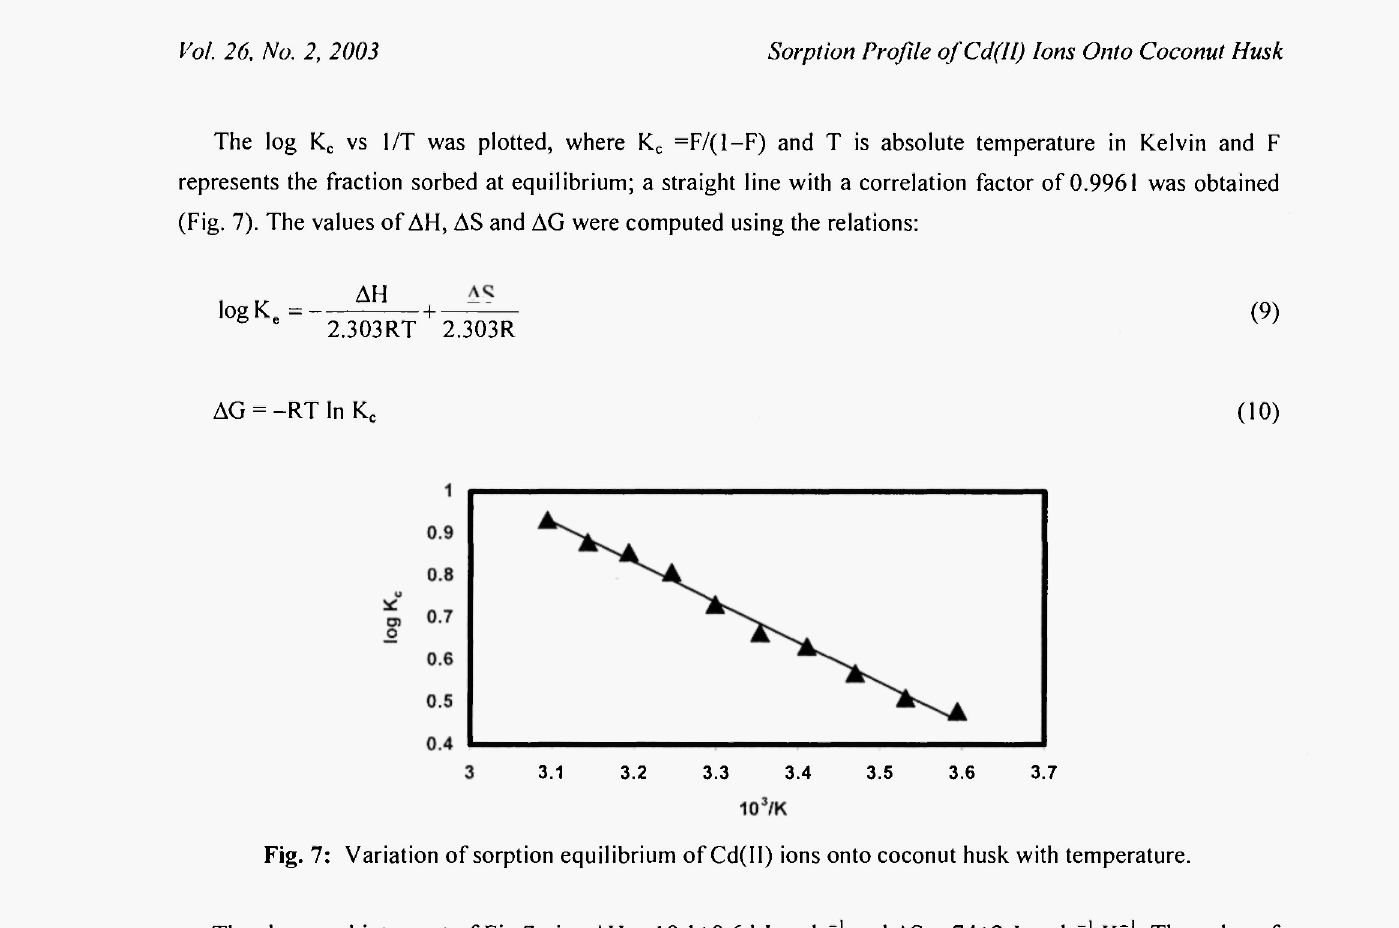
The slope and intercept of Fig.7 give ΔΗ = 18.1+0.6 kJ mole ' and AS = 74+2 J mole ' Κ '. The value